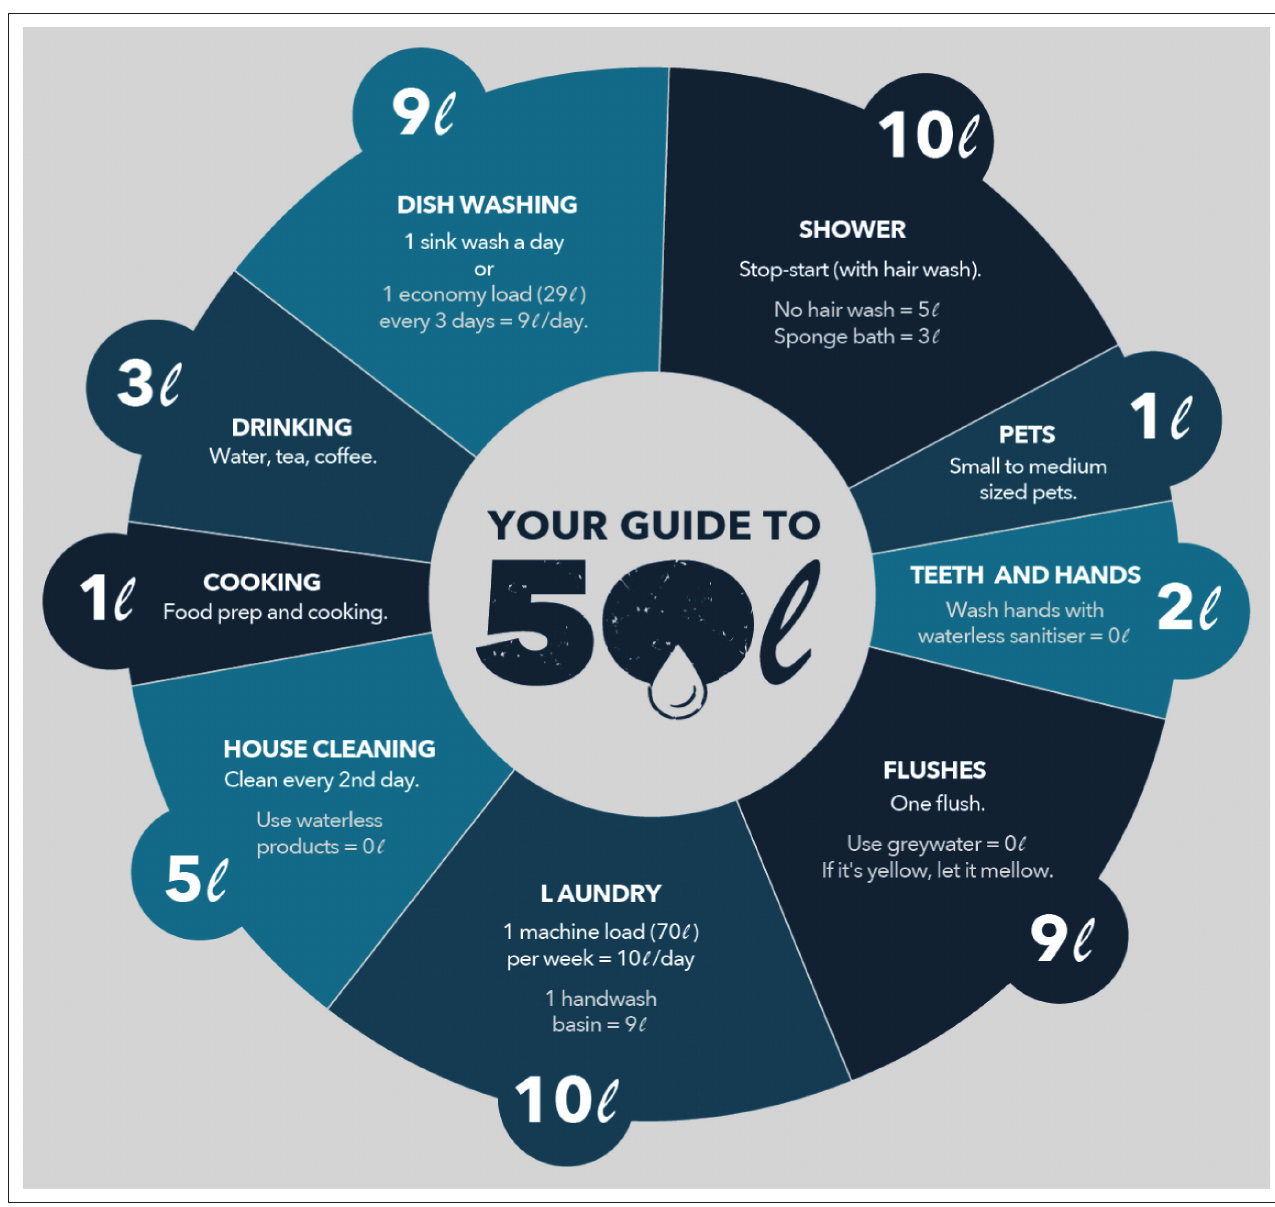
FIGURE 3: Using 50 L of water per day